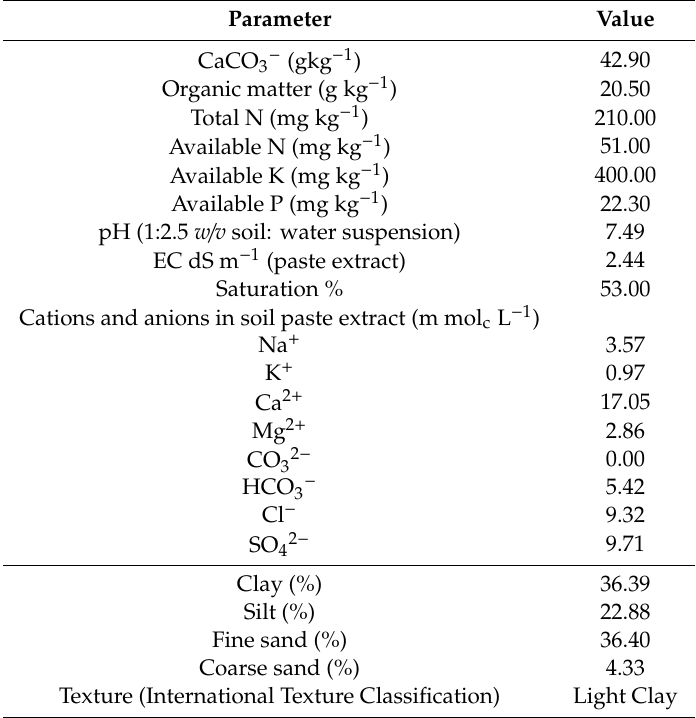
Table 2. Main physical and chemical properties of soil in the investigated area.